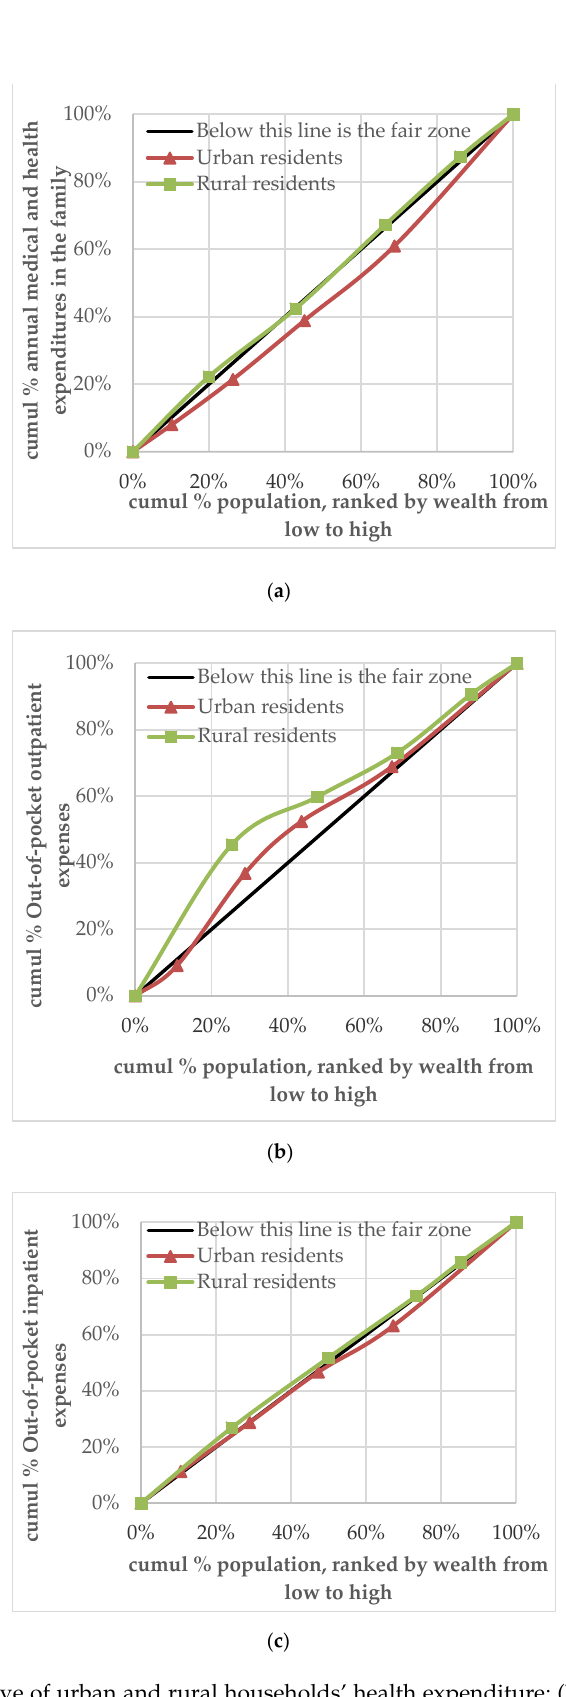
Figure 2. ( a ) Concentration curve of urban and rural households’ health expenditure; ( b ) concentration curve of urban and rural residents’ out-of-pocket payment for outpatient services; ( c ) concentration curve of urban and rural residents’ out-of-pocket payment for inpatient